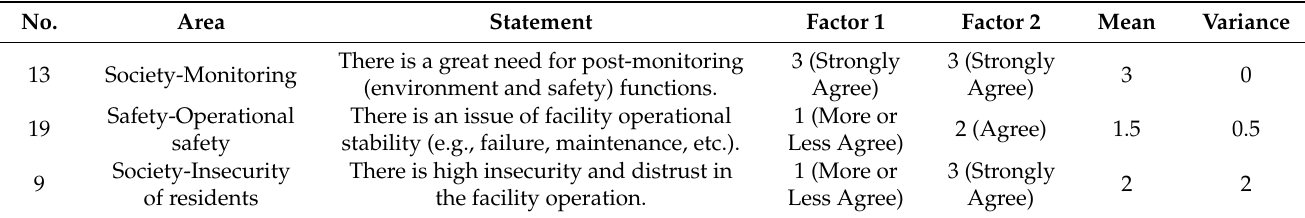
Table 10. Consensus statements on underground